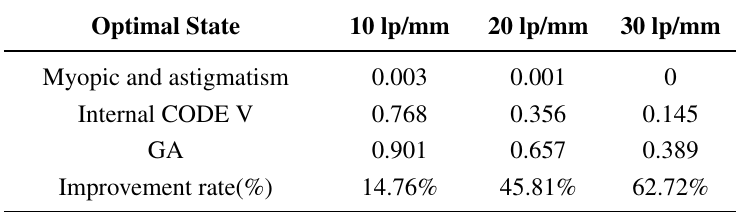
Table 14. Modulation transfer function (MTF) values for pupil size 5